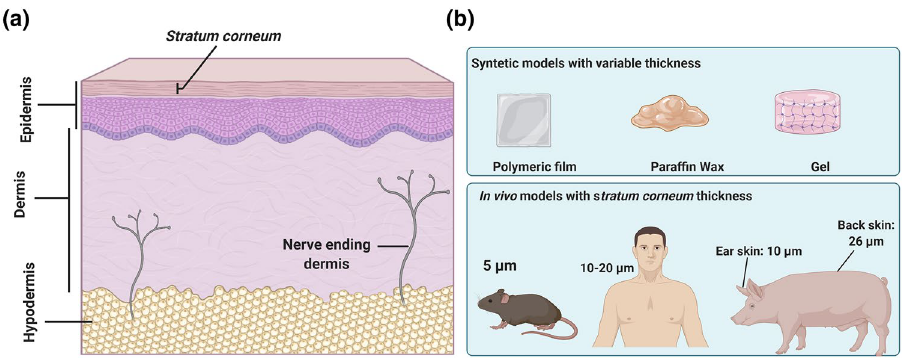
Fig. 7 a Diagram on human skin and its layer. b Schematic illustration of stratum corneum thickness for in vitro and in vivo microneedle inser-